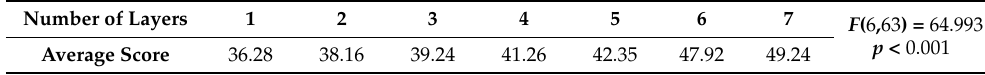
Table 15. NASA-TLX average cognitive load